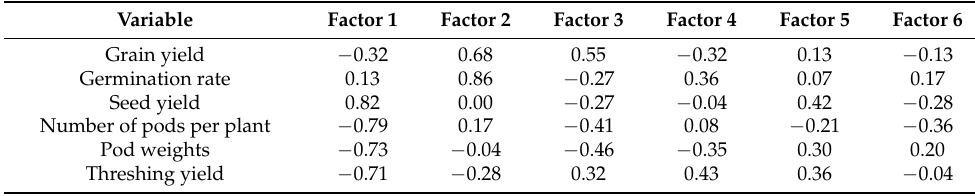
Table 2. Loading factors highlighted by PCA. Table 5. Result of a generalized additive model for the most essential studied plant traits.